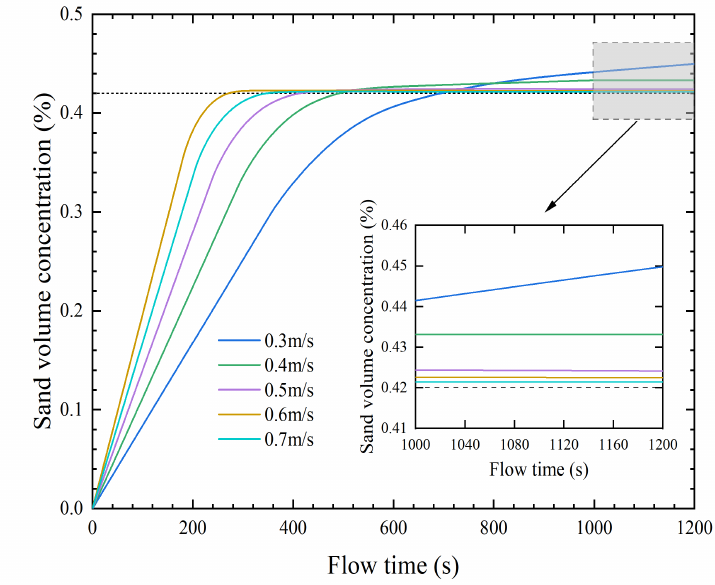
Figure 9. Sand volume concentration changes with flow time (V-inclined pipe L = 150 m d = 0.02 mm).